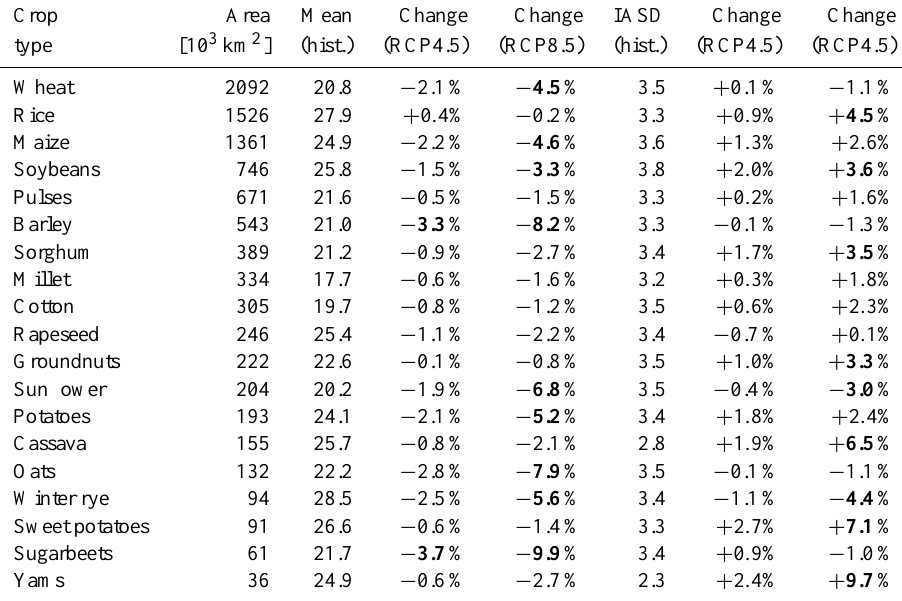
Table 2. Crop coverage-weighted statistics of mean and interannual standard deviation (IASD) of top 10cm soil moisture [kgm − 2 ] during the 20th century (hist.) and projected changes [%] from multi-model averages of 10 CMIP5 models. Changes of more than ± 3% are bold. Crop Area Mean Change Change